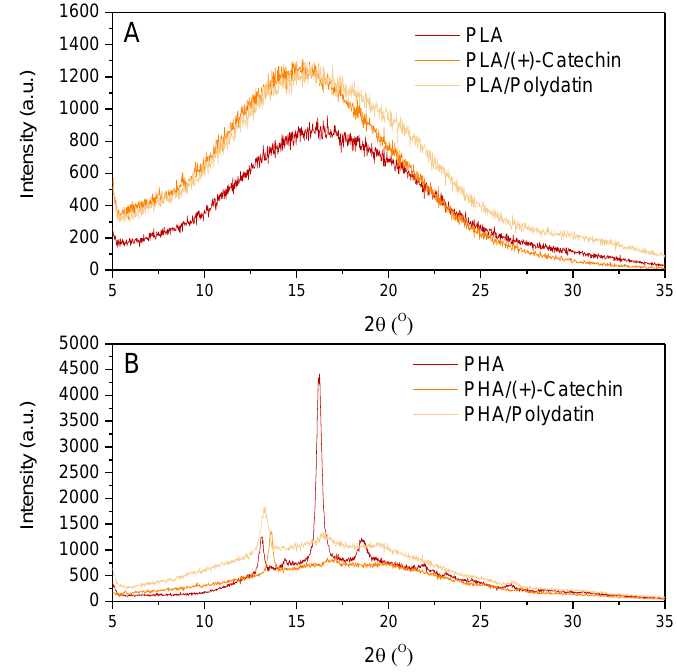
Figure 7. Wide angle X-ray diffraction (WAXD) spectra of PLA ( A ) and PHA ( B ) samples with polydatin and (+)-catechin.